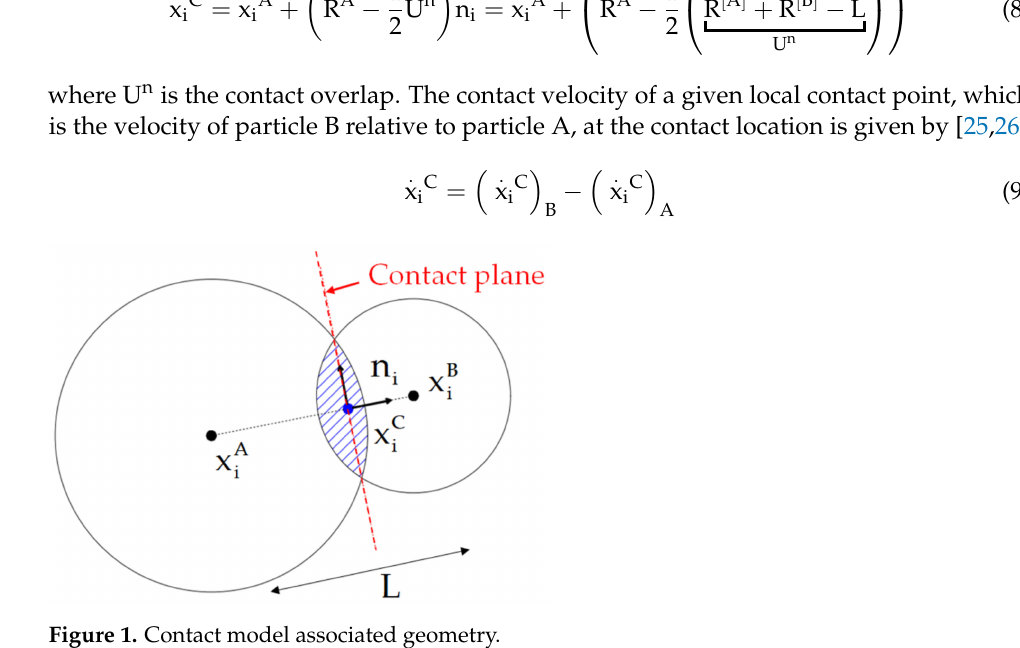
Figure 1. Contact model associated geometry.